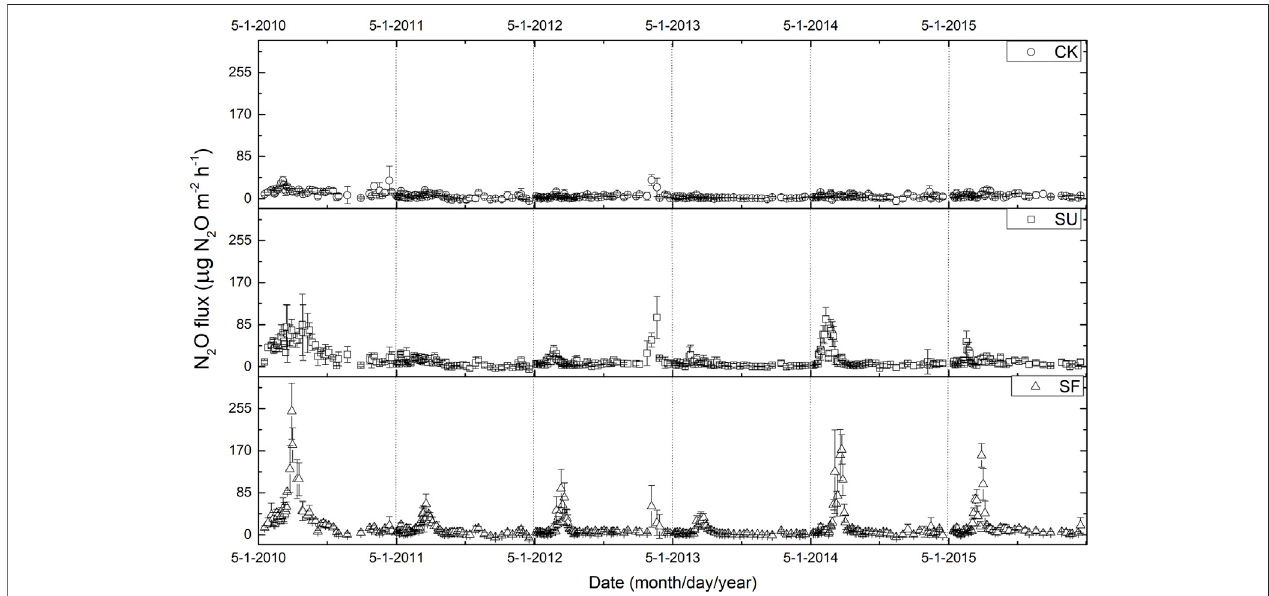
FIGURE3| SeasonaldynamicsofN 2 OemissionsintheCK,SU,andSFtreatmentsfromMay2010toApril2016.Thebarsrepresentthestandarddeviationsofthe means ( n (cid:2) 3).